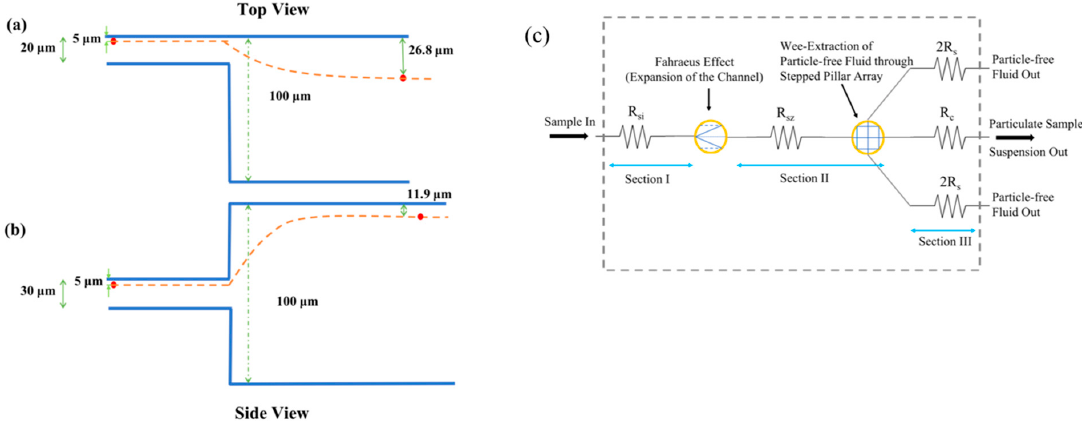
Figure 2. Schematics illustrating the movement of particle due to the expansion of the channel (Fahraeus e ff ect) and a hydraulic resistance model of the device. ( a , b ) represent the schematics illustrating the movement of the particle due to the expansion of the channel. Motion of the particle which was originally moving at 5 µ m away from the top and side walls prior to expansion of the channel is shown in ( a , b ), as seen in side and top views, respectively. The numbers shown in the figure were obtained from simulation results. ( c ) Schematic representing the hydraulic resistance model of the device. R si , R sz , R c and 2 R s are the hydraulic resistances of the appropriate sections / channels